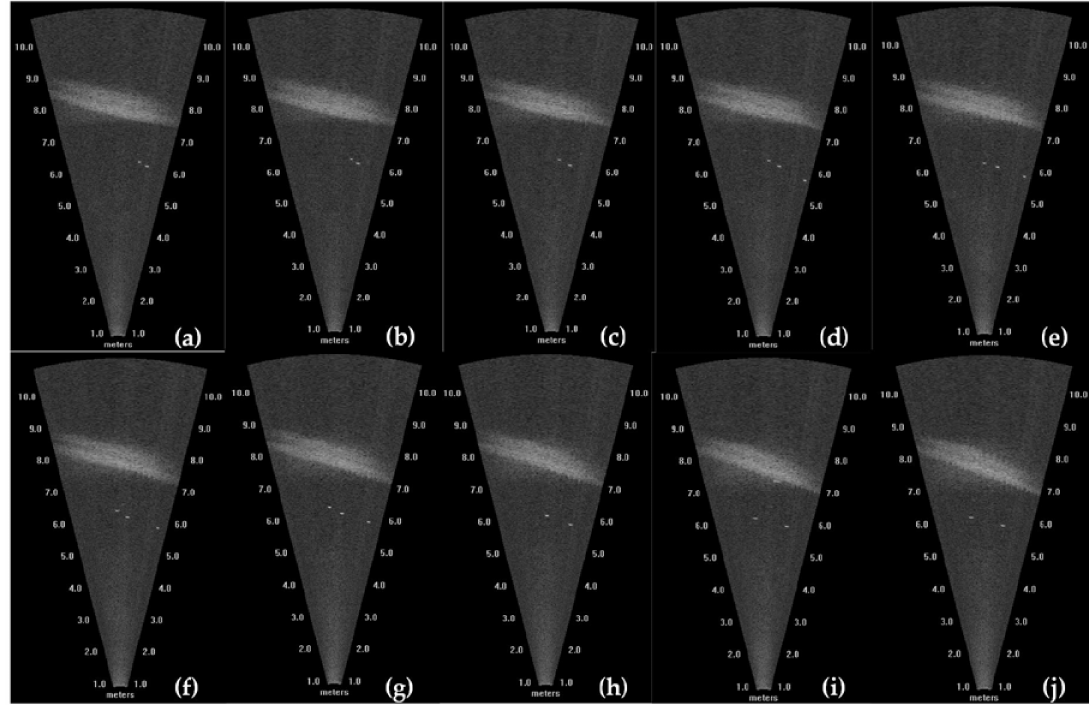
Figure 14. Charts of 10 consecutive frames. ( a – j ) represent these 10 consecutive